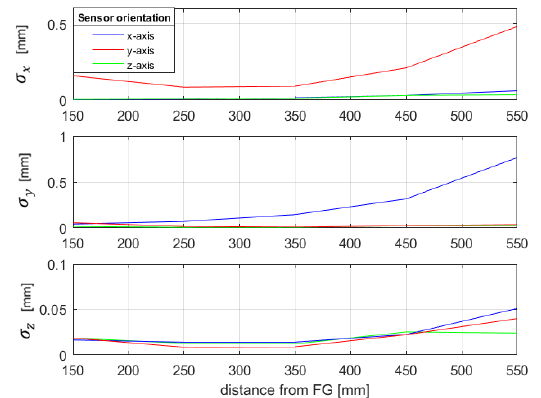
Figure 6. Position repeatability obtained with the estimation through gradients for different orientations of the sensor—EMTS prototype.